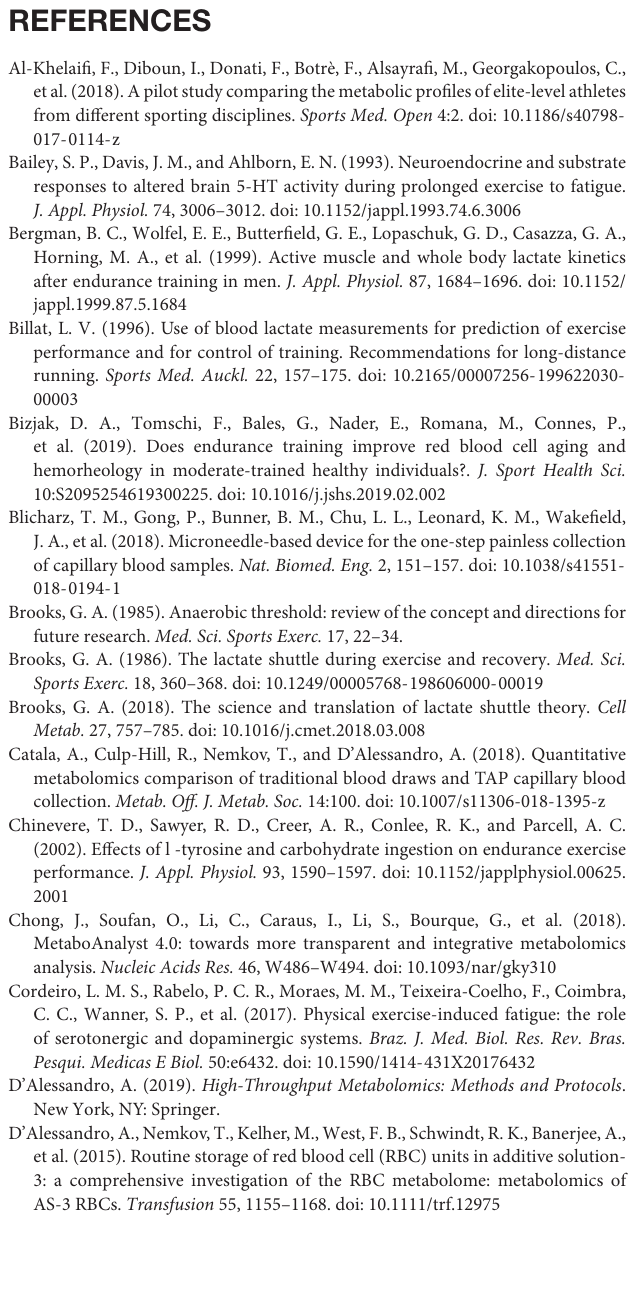
FIGURE S1 | Partial Least Squares Discriminant Analysis (PLS-DA) to determine metabolic co-variance between the Gold and Silver cycling groups is shown, along with the metabolites that most strongly contribute to the clustering pattern based on variable importance in projection (VIP) scores. FIGURE S2 | Urea Cycle metabolism. Samples from the Gold ( (cid:13) ) and Silver ( (cid:3) ) groups are shown Pre and Post exercise test (divided by a dotted line). p -values from a two-tailed paired T -test of comparisons between the Pre and Post time points using combined Gold/Silver group values are shown above the dashed line. p -values from a two-tailed unpaired homoscedastic T -test comparing the Gold and Silver groups at each time point are shown on the respective side of the dashed line. * p < 0.05; ** p < 0.01; *** p < 0.001; **** p < 0.0001.